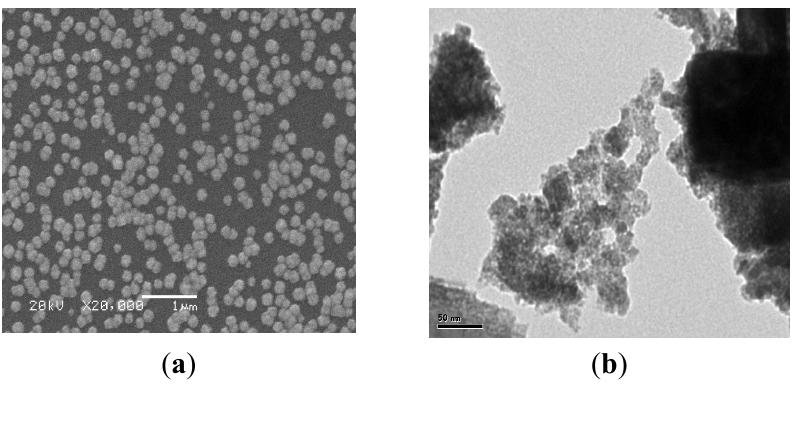
S )(PbS) thin films, ( a ) SEM; ( b ) 2 3